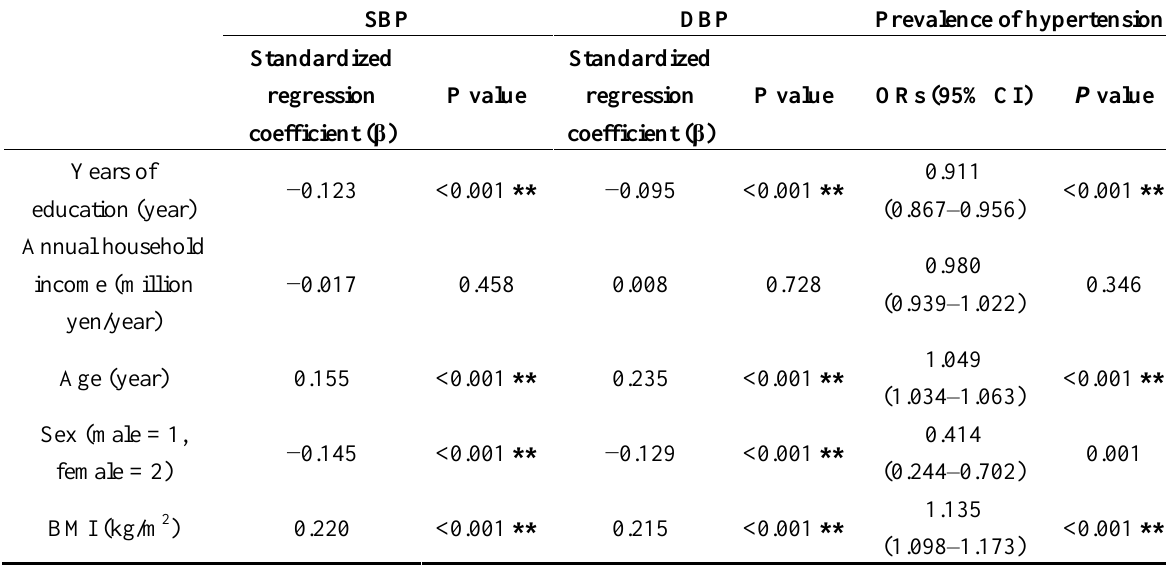
Table 4. The associations of SES factors with blood pressures (SBP and DBP) and the prevalence of hypertension. SBP DBP Prevalence of